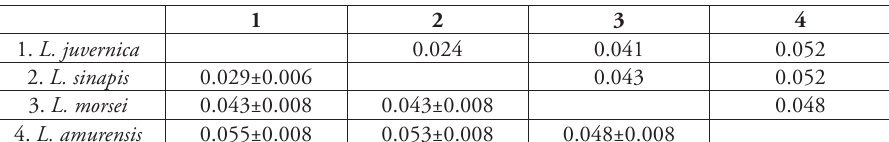
Table 3. Evolutionary Divergence over Sequence Pairs between Leptidea species in the studied sample as calculated from 34 COI gene sequences obtained. The number of nucleotide substitutions per site aver- aged over all possible specimens pairs for any two species, ± its standard error, is shown below the main diagonal, their minimum value among all specimens pairs for any two species is shown above the main diagonal. The total number of positions was